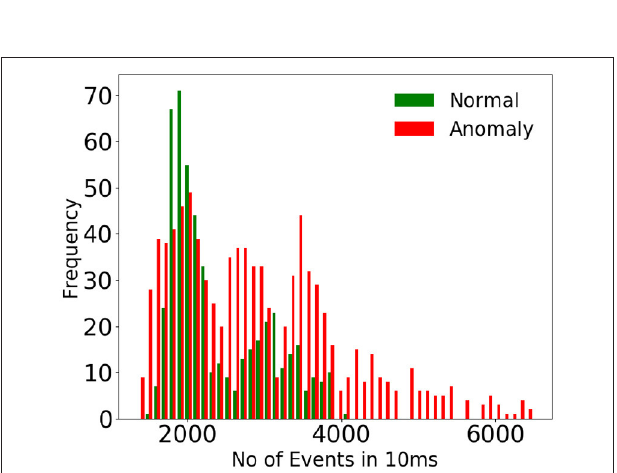
FIGURE 3 | Display of histogram of event rate of normal vs. anomalous activity. The event rates are estimated for a standard time interval of 10 ms. Huge overlap in the histogram of event rate indicates that the anomalous activities considered do not differ from normal activity in terms of rate of